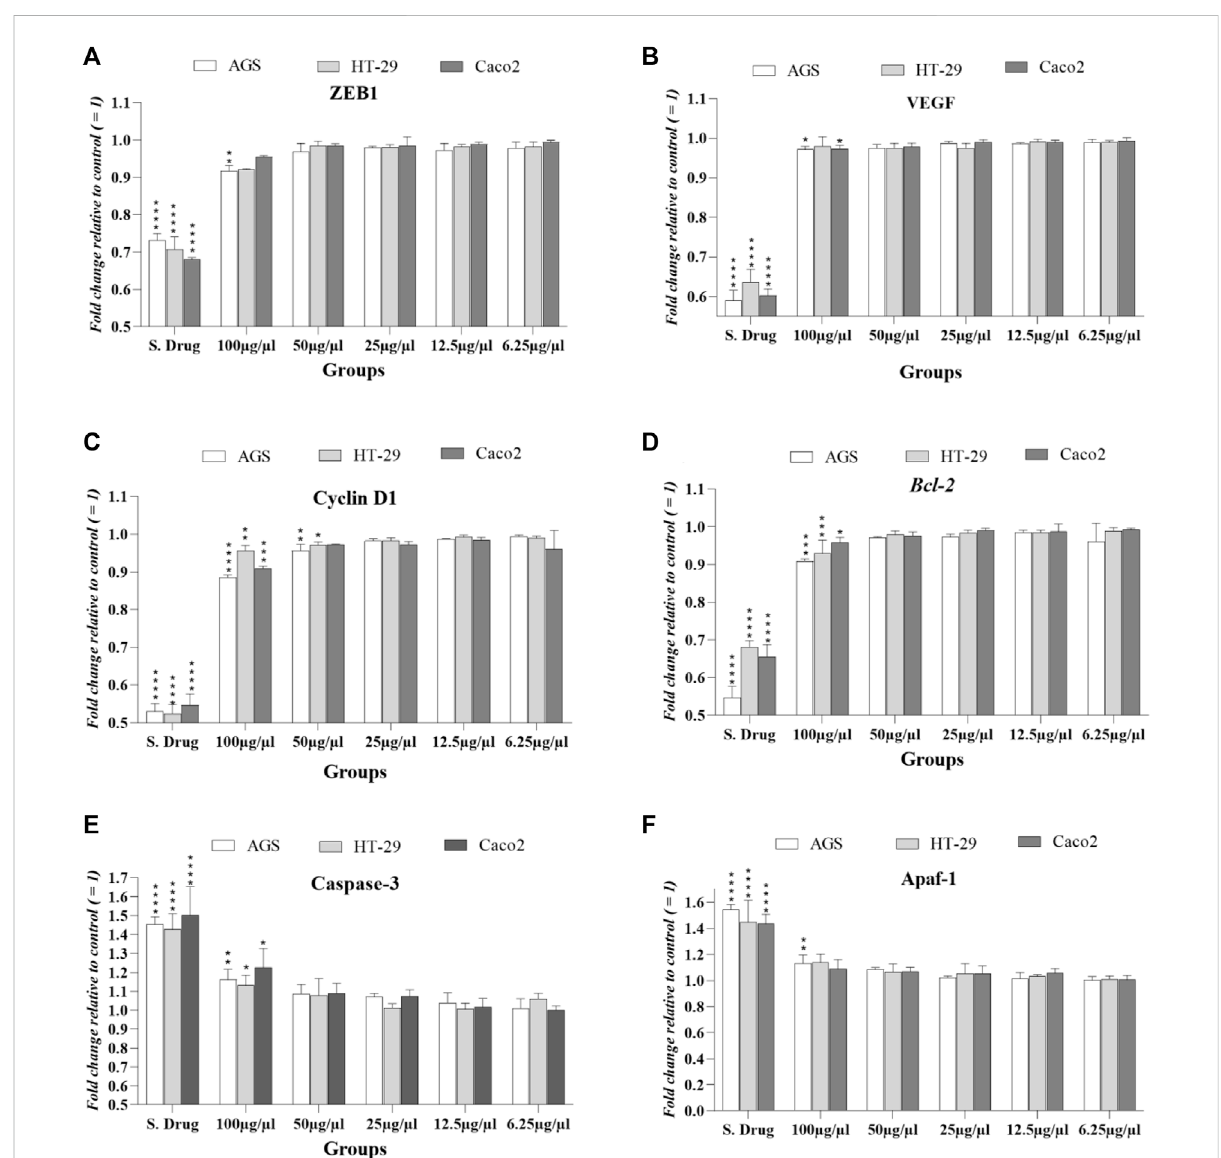
FIGURE 5 Expression levels of studied factors in three cancer cell lines exposed to T. canis ES PP and standard drug (regorafenib) in terms of fold change after 24 h exposure. Major expression changes occurred at 100 μ g/ml concentration, and in cyclin D (C), 50 μ g/ml concentration also induced signi fi cant changes in HT-29 and AGS cells; the groups were compared to the untreated